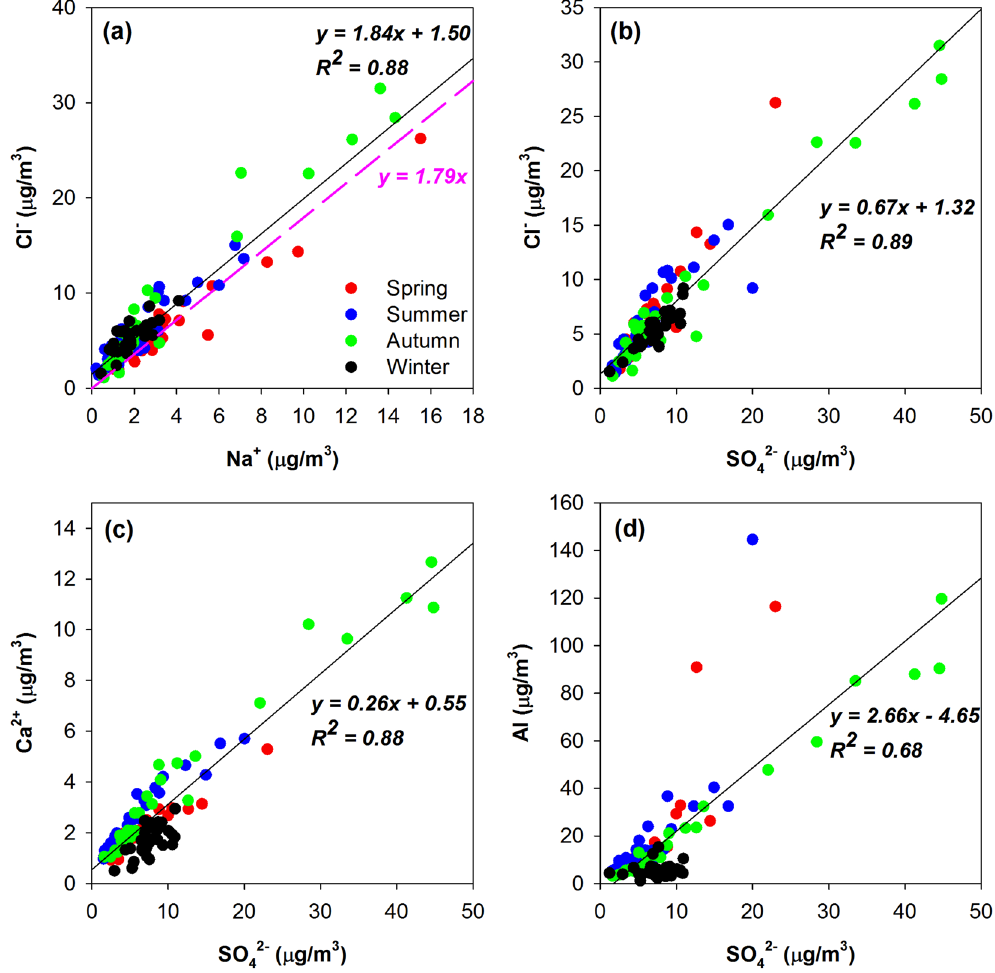
Figure 3. The relationship between ( a ) Cl − and Na + , ( b ) Cl − and SO 42 − , ( c ) Ca 2 + and SO 42 − , and ( d ) Al and SO 42 − . The samples in each season are denoted by different colors. Linear regression (black line) is fitted for the whole study period. The Cl − /Na + mass ratio of seawater 34 is represented by the purple dash line for reference in Fig.